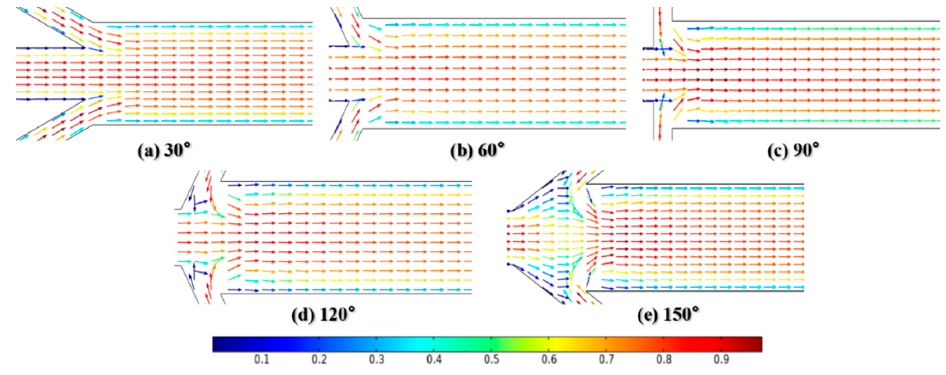
Figure 15. The distribution of velocity vector at Re = 0.1.